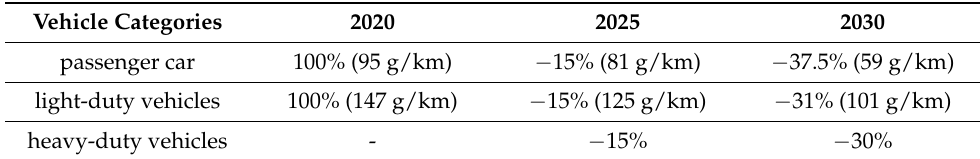
Table 1. Development of European fleet emission limit values in road traffic [14].